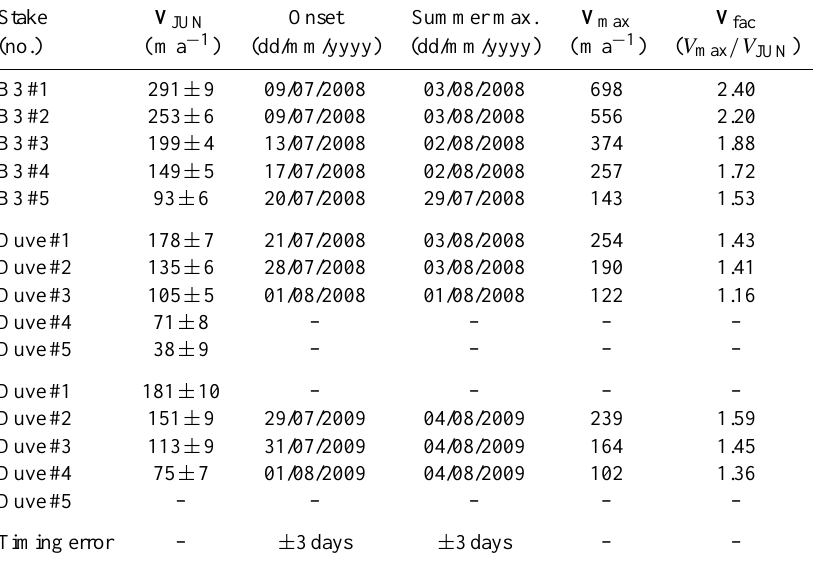
Table 3. Characteristics of the summer speed-up, following the pre-summer minimum in June, V JUN , in terms of the onset date, timing and value of measured maximum velocities, V max , and the normalized maximum flow enhancement relative to pre-summer velocities, V fac . Stake V